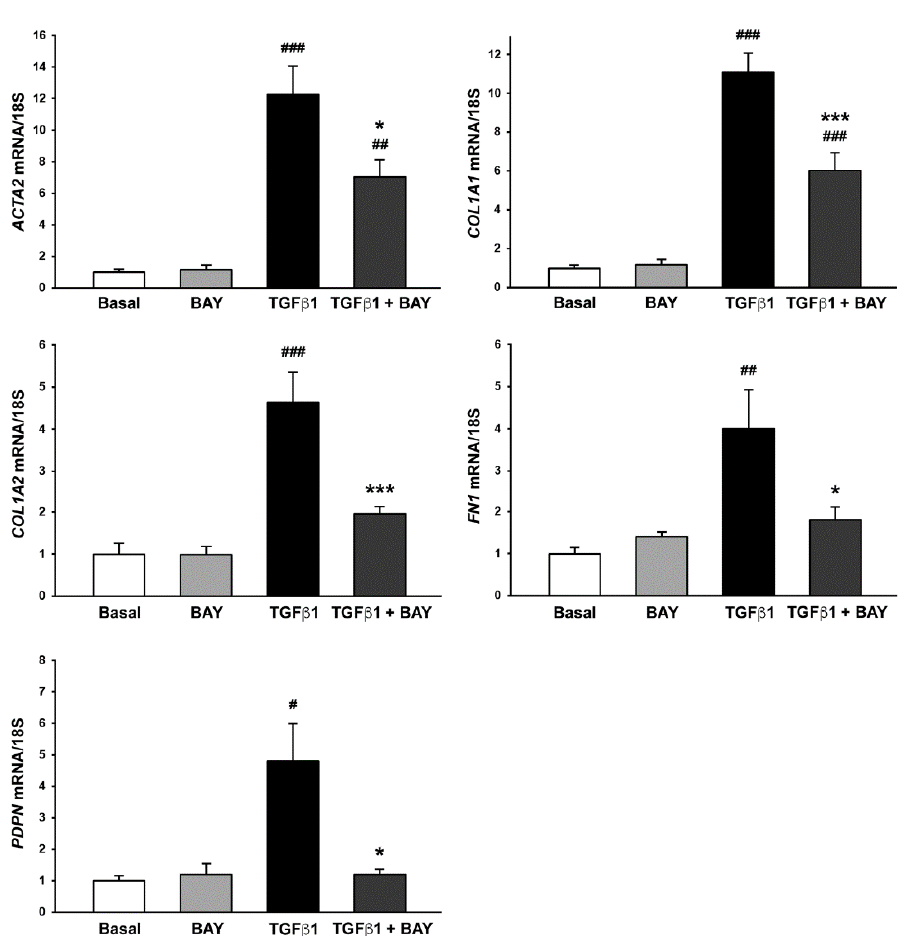
Figure 5. The soluble guanylate cyclase stimulator BAY 41-2272 significantly reduces TGF β 1-induced expression of genes encoding activated fibroblast/myofibroblast markers in human keratocytes. Gene expression of ACTA2 (gene encoding α -smooth muscle actin), COL1A1 (gene encoding α -1 chain of type I collagen), COL1A2 (gene encoding α -2 chain of type I collagen), FN1 (gene encoding fibronectin), and PDPN (gene encoding podoplanin) was evaluated by real-time PCR. The basal level of each gene expression was set to 1, and the other results are normalized to this value. 18S ribosomal RNA was used as reference gene. Bars represent the mean ± SEM of triplicate determinations from five cell lines. # p < 0.05, ## p < 0.01, ### p < 0.001 vs. basal condition, * p < 0.05, *** p < 0.001 vs. TGF β 1 alone (Tukey’s test). SEM, standard error of the mean; TGF β 1, transforming growth factor β 1 .